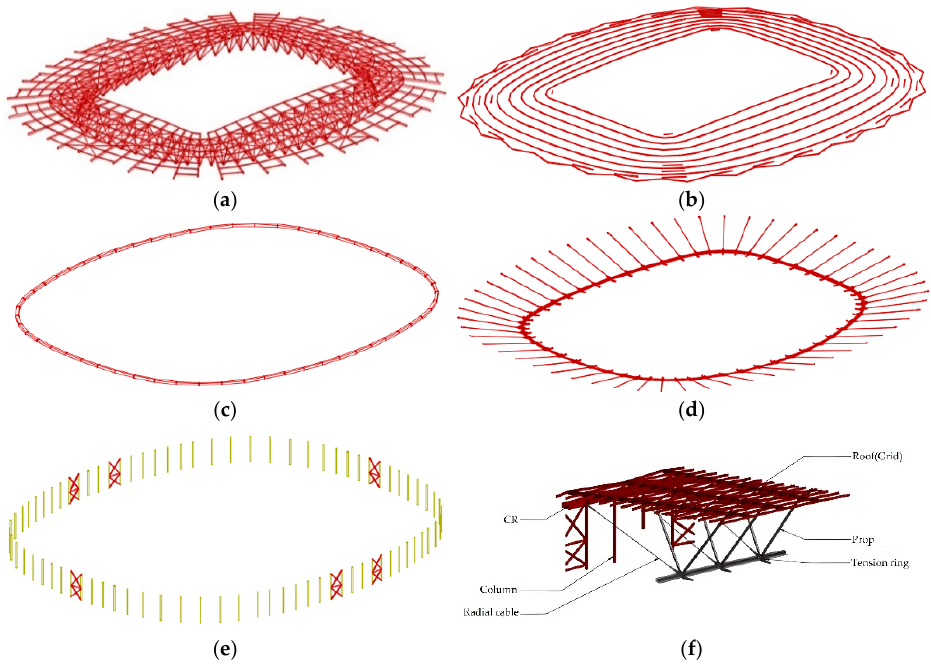
Figure 3. Detailed 3D axonometric drawings: ( a ) upper main steel members (radial main beams, braces, etc.), ( b ) roof purlins, ( c ) outer compression ring, ( d ) cable net system (radial cables + tension rings), ( e ) structural columns and crossing braces between columns, ( f ) partial overall structure. Table 1. Cable materials and